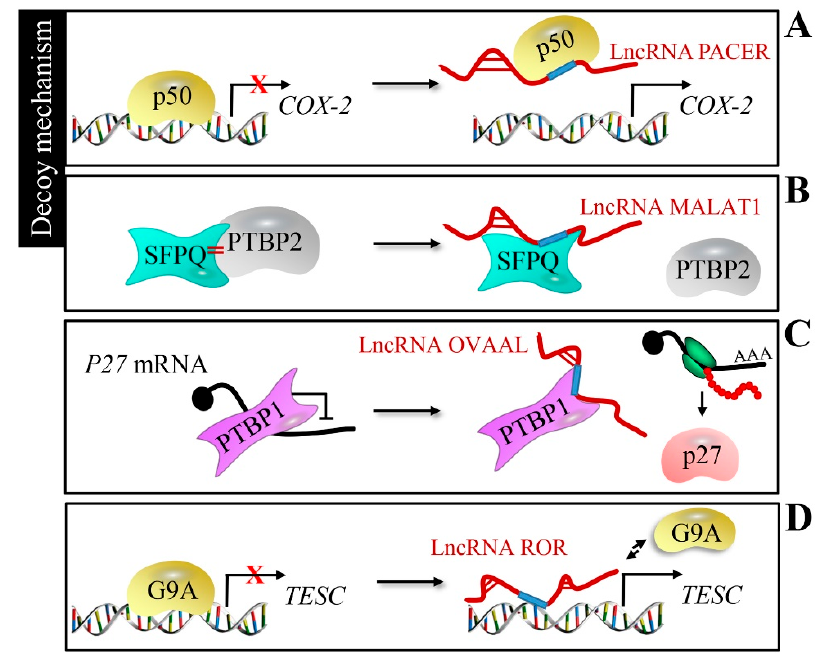
Figure 3. Decoy mechanism of lncRNAs. ( A ) LncRNA PACER interacts with the p50 to separate it from the cytochrome c oxidase subunit II ( COX-2 ) promoter, activating COX-2 gene expression. ( B ) LncRNA MALAT1 binds to SFPQ and releases oncogene PTBP2 from the SFPQ/PTBP2 complex. ( C )